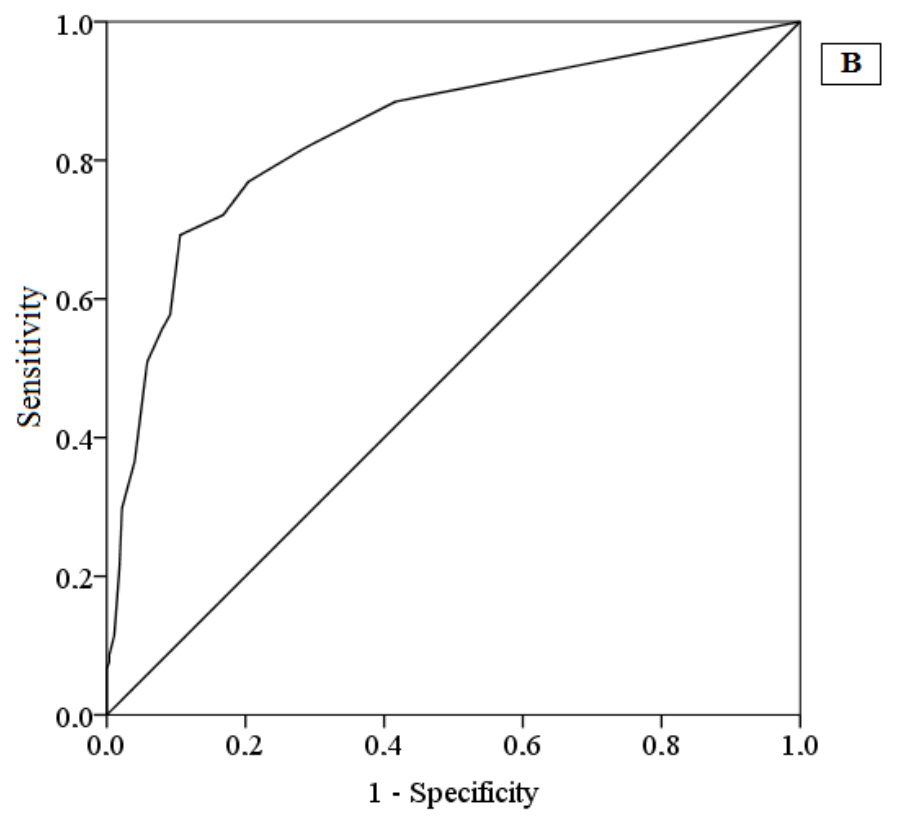
Figure 1. Receiver operating characteristic curve of the OASIS ( A ) and ODSIS ( B ).